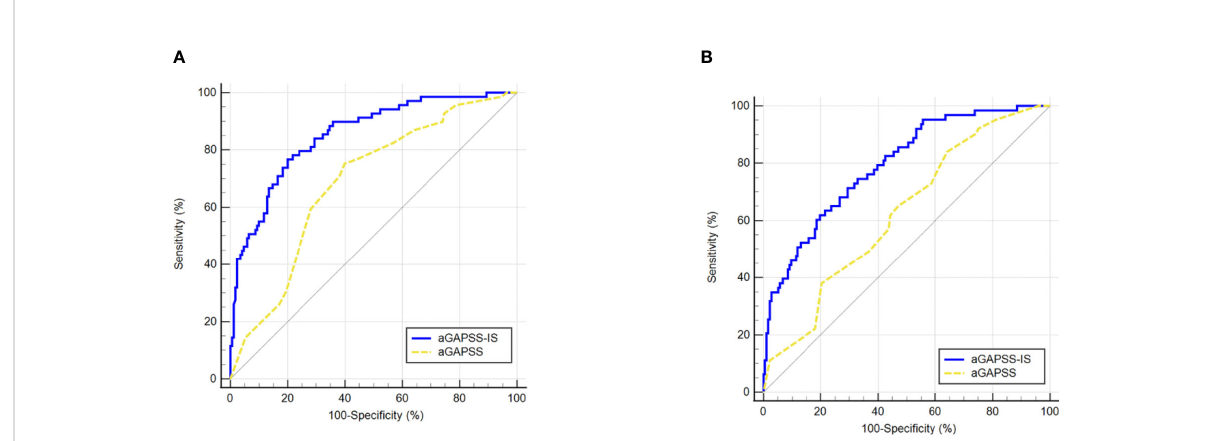
FIGURE 3 Comparison of the area under the receiver operating characteristic curve values between aGAPSS-IS score and aGAPSS in the training and the validation cohort. (A) In the training cohort, the aGAPSS-IS score had a larger AUROC than the aGAPSS [0.853 (95% CI, 0.802-0.896) vs. 0.686